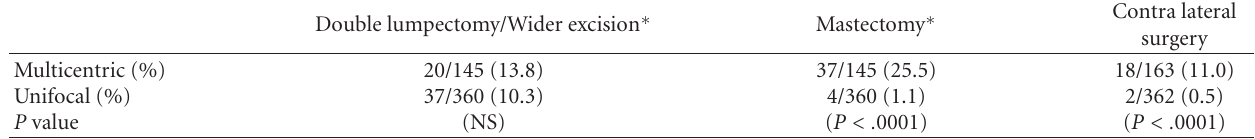
Table 7: Multicentric versus unifocal cancer in the subgroups.